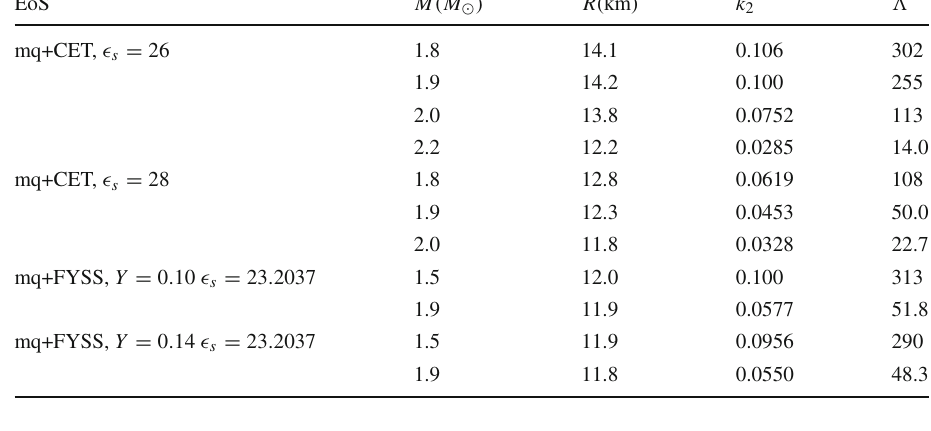
Table 3 Dimensionless tidal deformation (cid:2) 1 , (cid:2) 2 and combined dimensionless tidal deformation ˜ (cid:2) of binary systems of NS with multiquark core and nuclear CET/FYSS